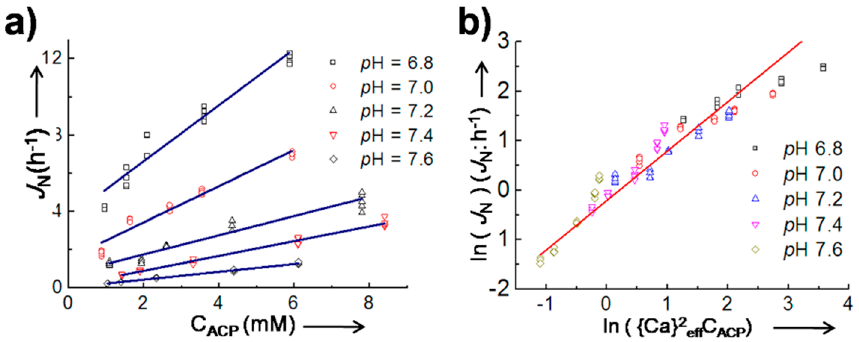
Figure 8. Nucleation rate, J N , was related to ( a ) the amount of precipitated amorphous calcium phosphate (ACP) (C ACP , mM) and ( b ) effective calcium activity ({Ca 2+ }, mM). Reproduced with permission from the Royal Society of Chemistry in Reference [10].